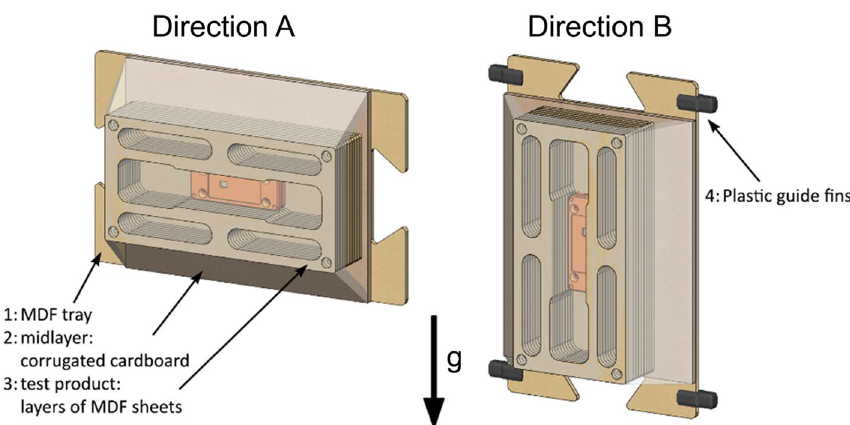
Fig. 5 Test package orienta-